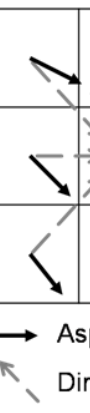
Figure 2. Convergence Index calculation. 2 Fig. 2. Convergence Index